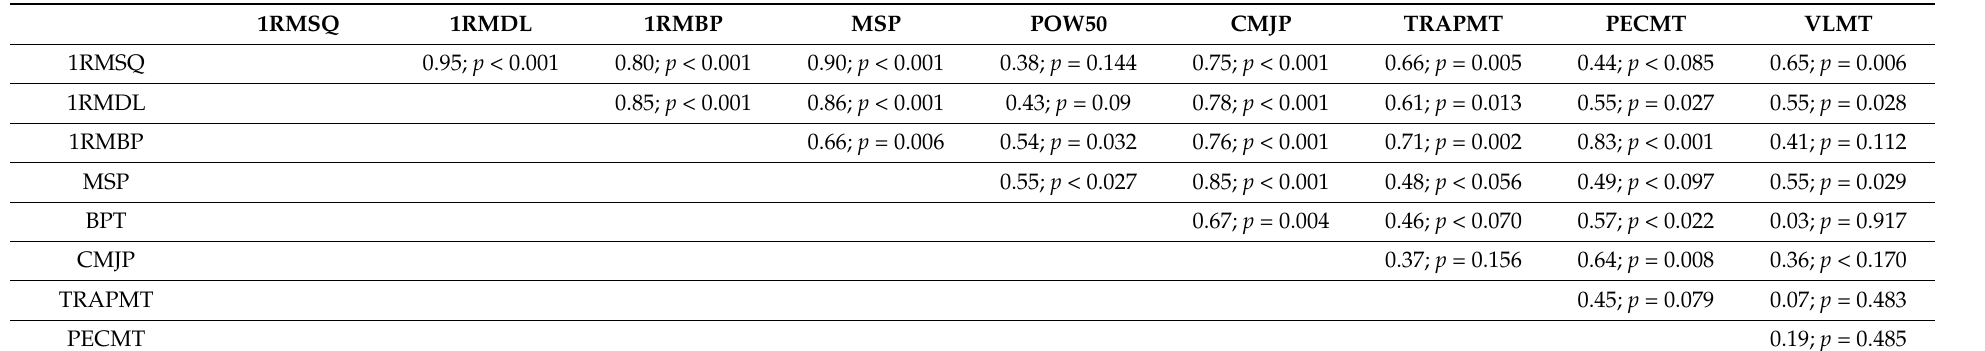
Table 3. Correlations between the different parameters of performance and muscle morphology in male group. 1RMSQ = 1RM squat; DL = deadlift; BP = bench press; MSP = mid-shin pull; BPT = bench press throw; CMJP = countermovement jump power; TRAPMT = muscle thickness of trapezius muscle; PECMT = muscle thickness of pectoral muscle; VLMT = muscle thickness of vastus lateralis.